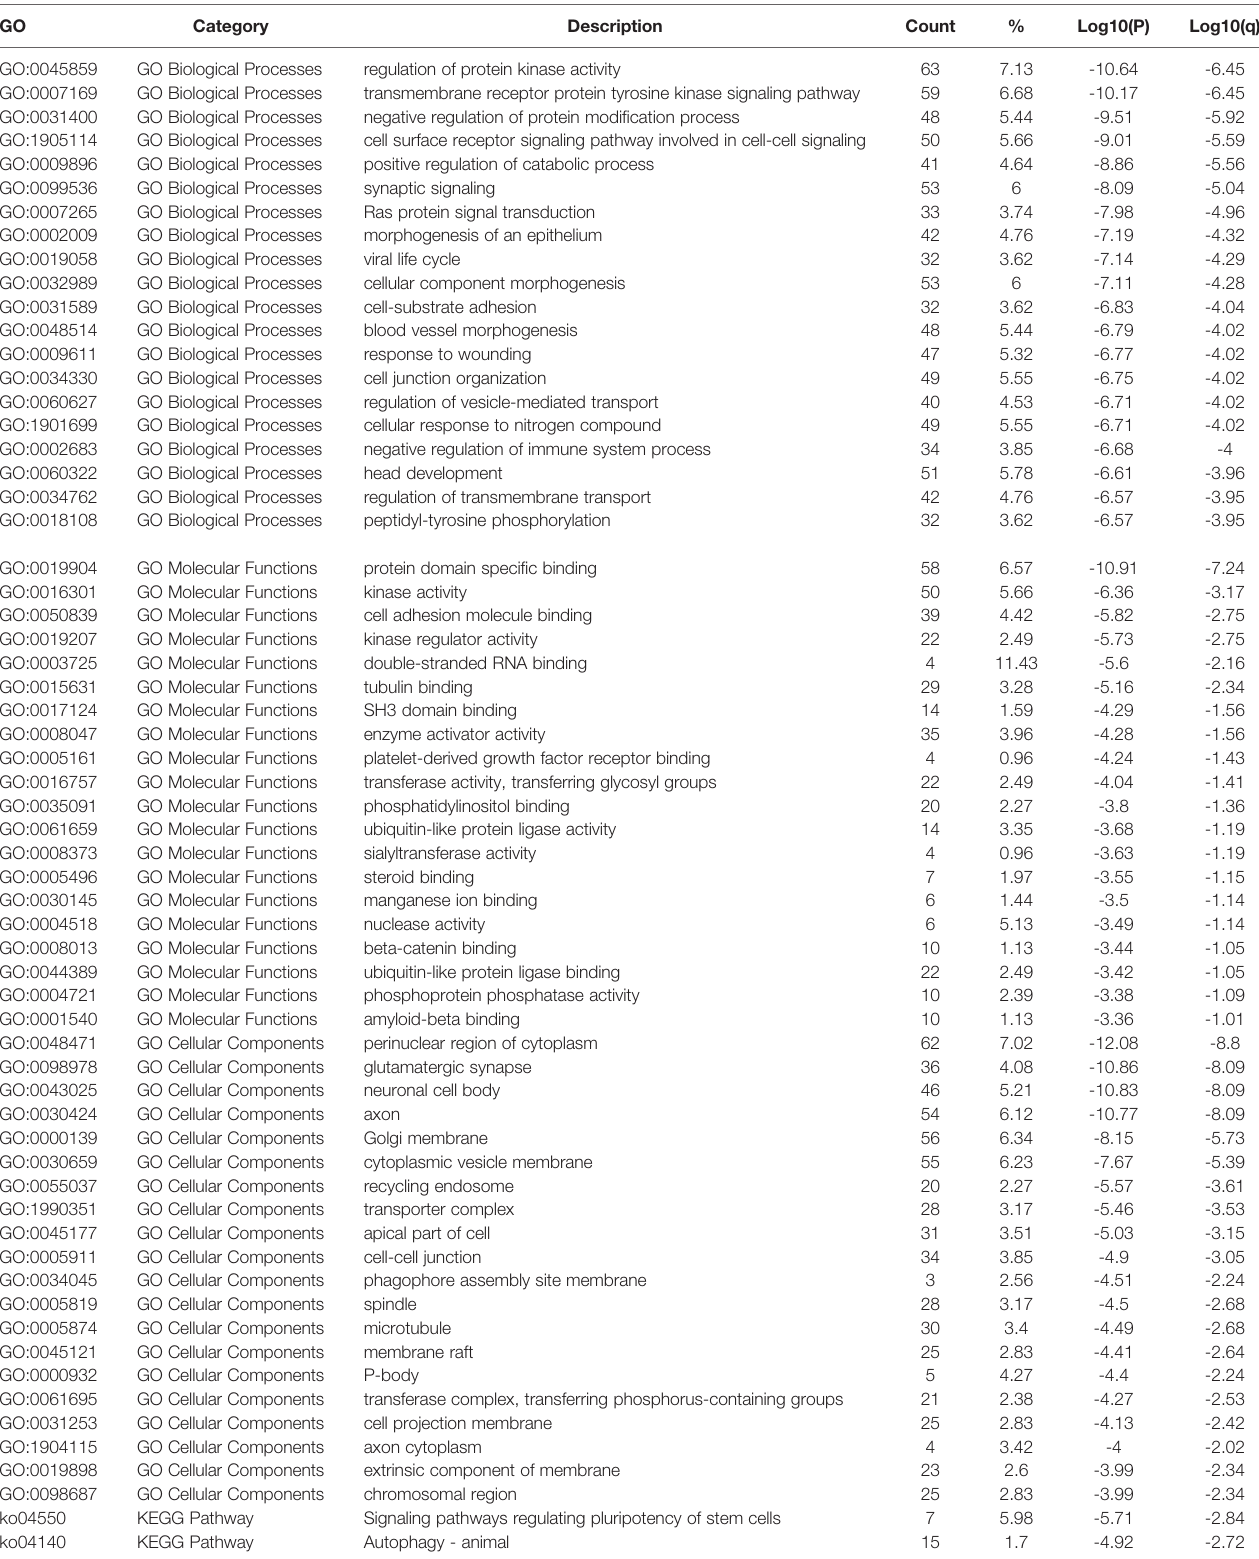
TABLE 2 | List of enriched